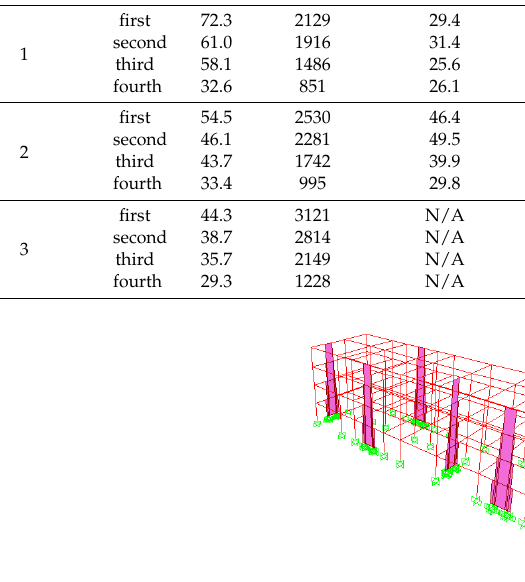
Figure 17. Layout of added walls.